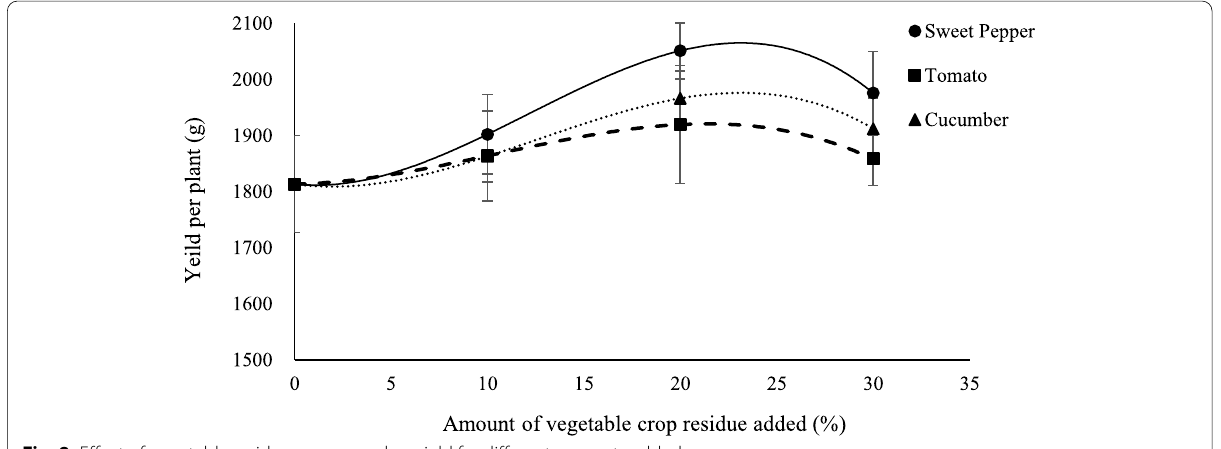
Fig. 8 Effect of vegetable residues on cucumber yield for different amounts